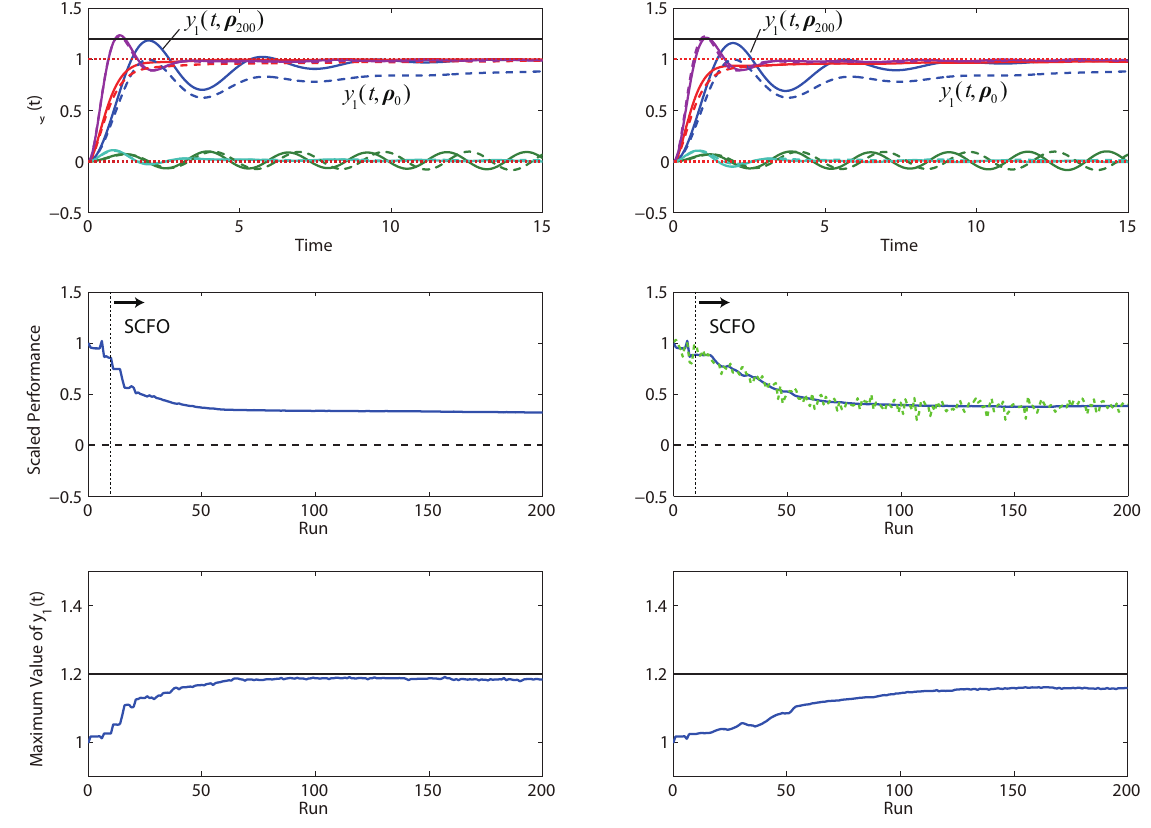
Figure 16. Performance obtained by iterative tuning for the system of PI controllers in Problem (22)—the noiseless case is given on the left and the noisy case on the right. For the output profiles, we note that the initial profiles are given as dashed lines, with the final profiles given by solid lines of the same